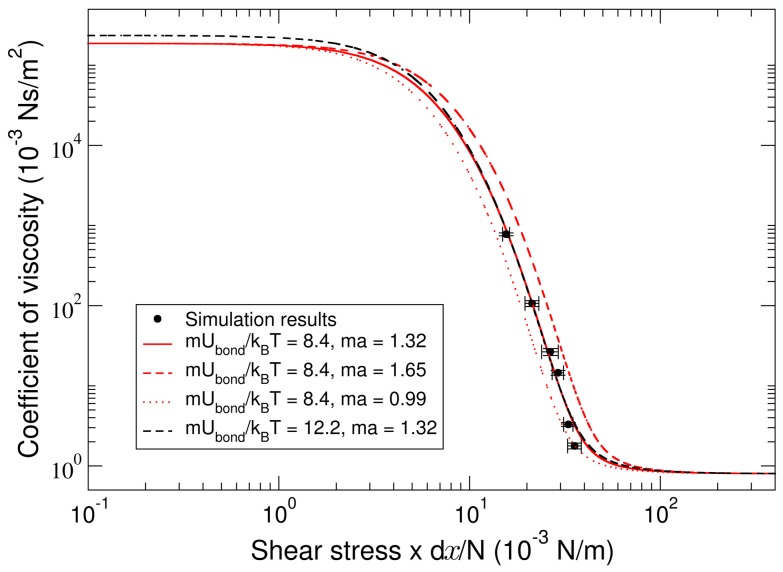
Simulated coefficient of viscosity per residue as a function of shear stress .Red and black lines present fits of the stochastic model to the simulation data with varying ma and , respectively. The solid red line shows the best fit to the data.